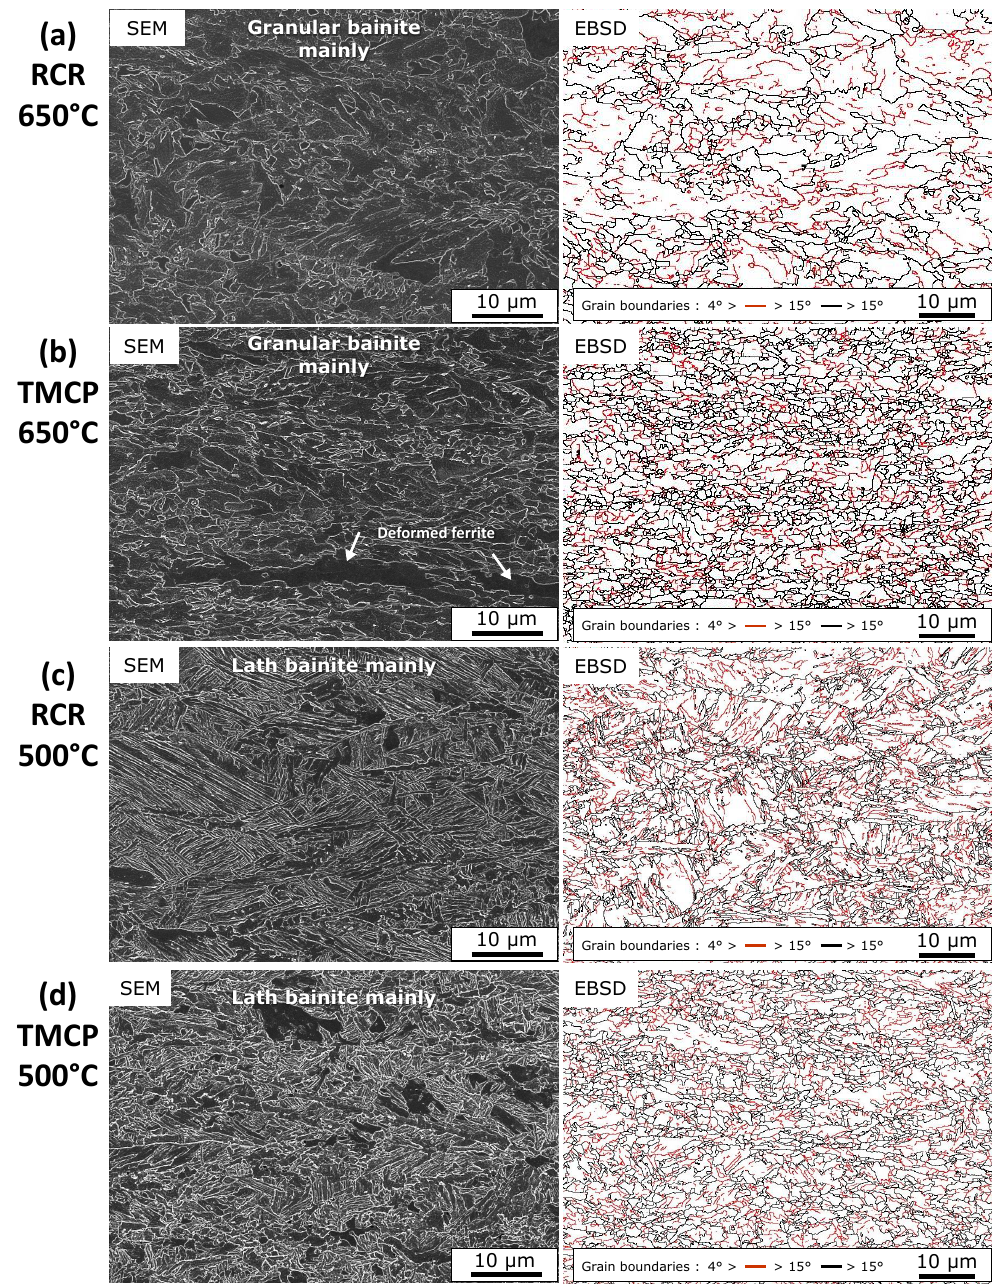
Figure 7. Microstructures of ( a ) RCR-650 ◦ C, ( b ) TMCP-650 ◦ C, ( c ) RCR-500 ◦ C, and ( d ) TMCP-500 ◦ C characterized by SEM and EBSD. Grain boundary maps showing grain boundaries between 4 ◦ and 15 ◦ in red and above 15 ◦ in black are